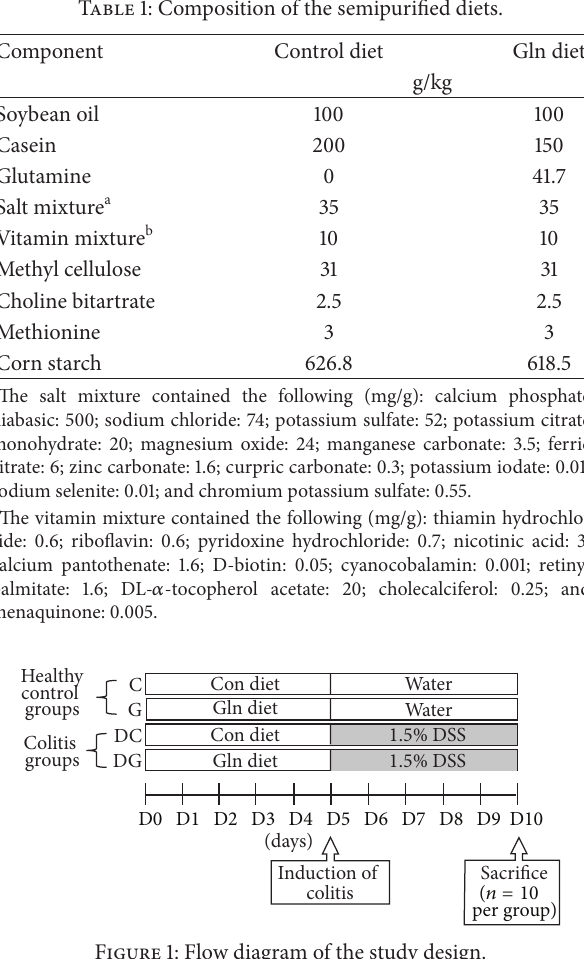
Figure 1: Flow diagram of the study